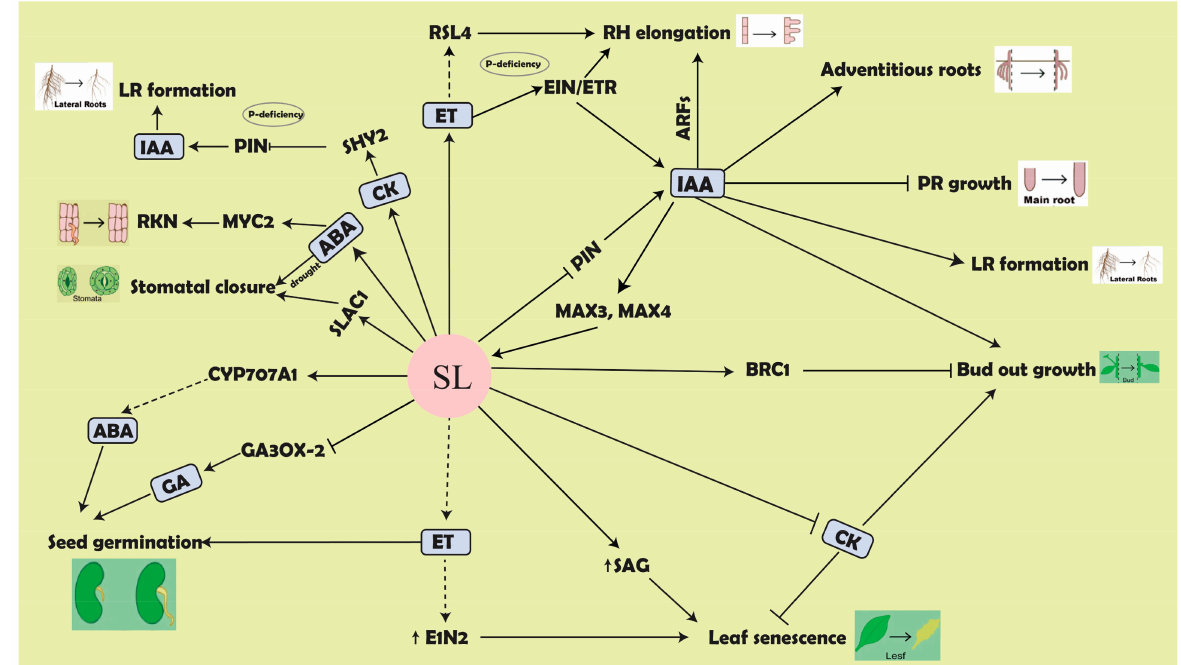
Figure 3. Possible interaction of SLs with different phytohormones. SLs regulate different features by interaction with other phytohormones. SLs increase the PR length and inhibit the LR initiation and bud outgrowth by suppressing the auxin transporter (PIN). SLs increase the abundance of BRC1 and also inhibit CK activity, which as a result stops the bud outgrowth. The expression of SAG increases which stimulates the leaf senescence. The interaction of SLs and ABA is dependent on the condition, such as in stressful conditions both phytohormones up-regulate. SLs regulate the ABA catabolic gene CYP707A1 and decrease the ABA content to regulate seed germination, while under hostile conditions, SLs activate SLAC1 which induce the closure of stomata in an ABA-independent manner. SLs stop the accumulation of ABA and inhibit MYC2 expression and RKN infection. SLs decrease the GA3ox2, a key enzyme in GA production and 9-cis-epoxycarotenoid dioxygenases (NCED), at 32 ◦ C to regulate seed germination. SL increases the ET that increases the EIN and RSL4 signaling and regulates RH and leaf senescence. Abbreviations: PR, primary roots; LR, lateral roots; RH, root hair; IAA, auxin; GA, gibberellic acid; CK, cytokinin; ABA, abscisic acid; ET, ethylene; SL, strigolactone; SAG, senescence-associated gene; SLAC1, Slow Anion Channel Activating 1; RKN, root-knot